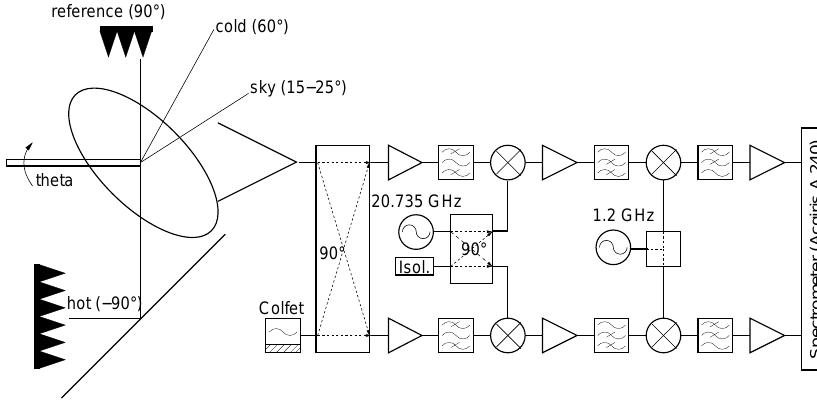
Fig. 2. Block diagram of the correlation receiver of MIAWARA-C.